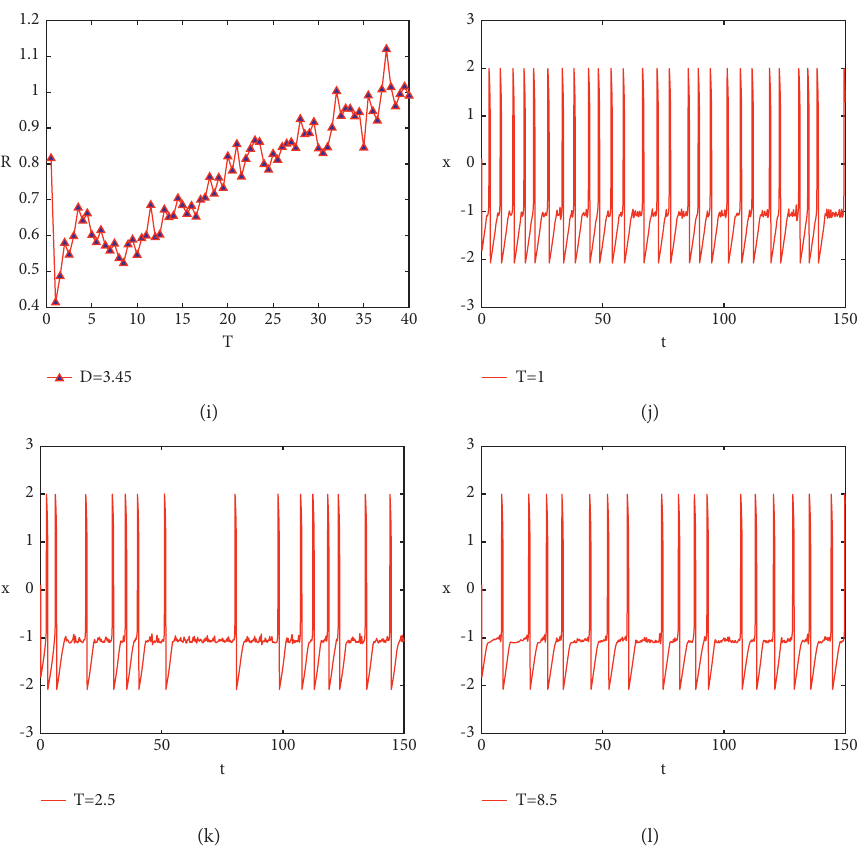
Figure 11: When the phase noise intensity varies, the variation of coherence resonance coefficient R with period T of phase noise and the time evolution diagram of the system membrane potential x . (a)When D � 0 . 05, variation of R with T ; (b) D � 0 . 05, T � 9; (c) D � 0 . 05, T � 17; (d) D � 0 . 05, T � 35; (e)When D � 0 . 5, variation of R with T ; (f) D � 0 . 5, T � 3; (g) D � 0 . 5, T � 4; (h) D � 0 . 5, T � 11 . 5; (i)When D � 3 . 45, variation of R with T ; (j) D � 3 . 45, T � 1; (k) D � 3 . 45, T � 2 . 5; (l) D � 3 . 45, T � 8 .